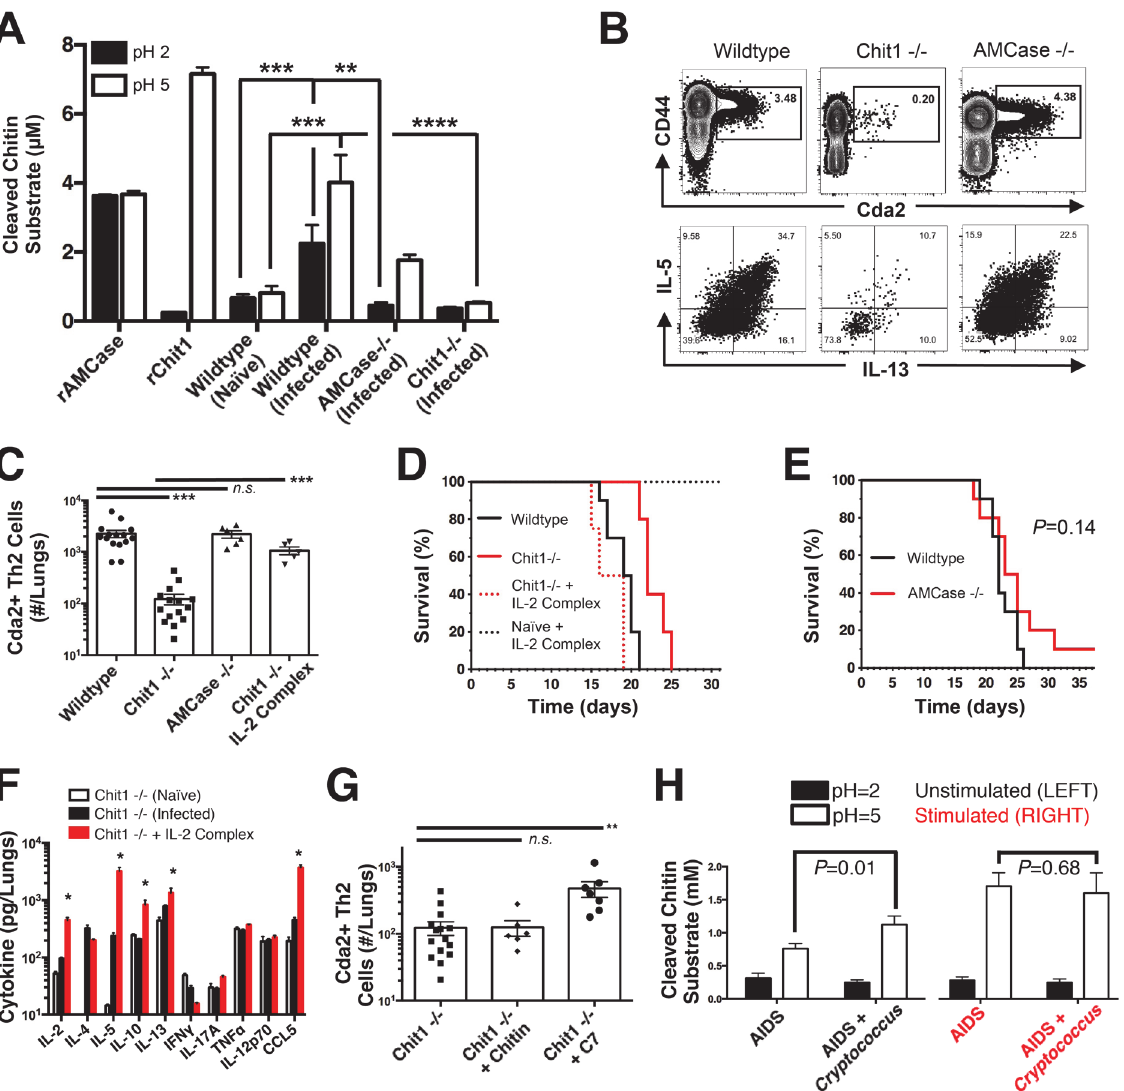
Fig 6. Chitotriosidase Promotes Chitin Recognition and Th2 Cell-mediated Disease. ( A ) Chitinase enzyme activity of recombinant enzymes or lung homogenates from 14 days post-infected or na ï ve mice. ( B ) Flow cytometry plots of CD4+, Foxp3-, CD44+ Cda2+ Th cells expressing Th2 cytokines, IL-5 & IL-13, at 14 days post-infection and ( C ) the quantification of these plots. ( D&E ) Survival of mutant or wildtype mice infected with KN99 α either with or without IL-2 complex treatment. Logrank test comparing each survival curve relative with 10 mice for each group to: Chit1 − / − vs. wildtype, P < 0.005; Chit1 − / − vs. Chit1 − / − + IL-2 complex, P < 0.0005; Chit1 − / − + IL-2 complex vs. wildtype, P = 0.07. ( F ) Cytokines from lung homogenates of na ï ve or wildtype and Chit1 − / − mice 14 days post-infection with KN99 α or age-matched, na ï ve Chit1 − / − mice. ( G ) IL-5+ IL-13+ antigen-specific Th2 cells from lungs of Chit1 − / − mice 14 days post-infection and mice treated with intranasal chitin particles or chitin heptamer fragments (C7). ( H ) Chitinase enzyme activity of human plasma without (LEFT) or with (RIGHT) cryptococcal lysate antigen stimulation. Data are presented as the mean +/- standard error with at least 2 independent experiments per group. * = P < 0.05, ** = P < 0.005, *** = P < 0.0005 by Mann-Whitney U or Kruskal Wallis ANOVA. AMCase = Acidic Mammalian Chitinase, C7 = chitin heptamer, CCL = chemokine ligand, Cda = chitin deacetylase, Chit1 = Chitotriosidase, IFN = interferon, IL = interleukin, TNF = tumor necrosis